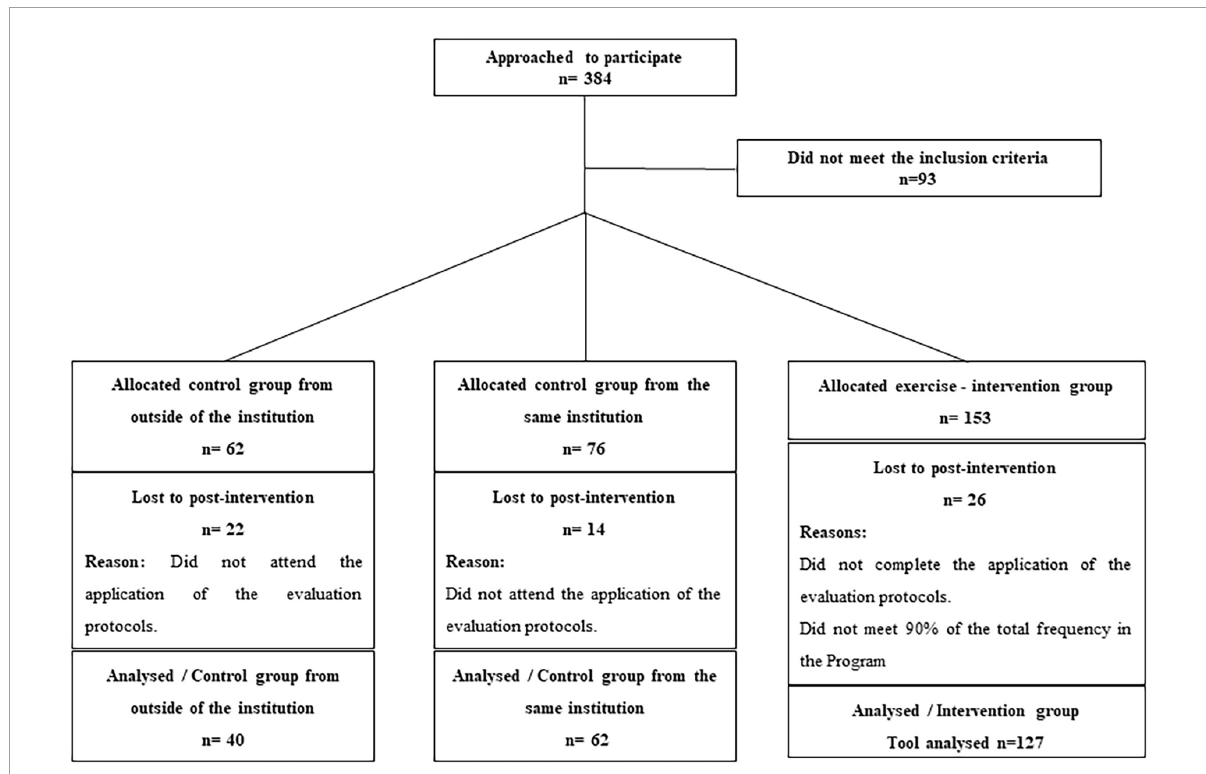
FIGURE1 A controlled trial of the effects of a physical exercise program on the symptom profile of children and adolescents with ASD. Error bars indicate the 95% credible